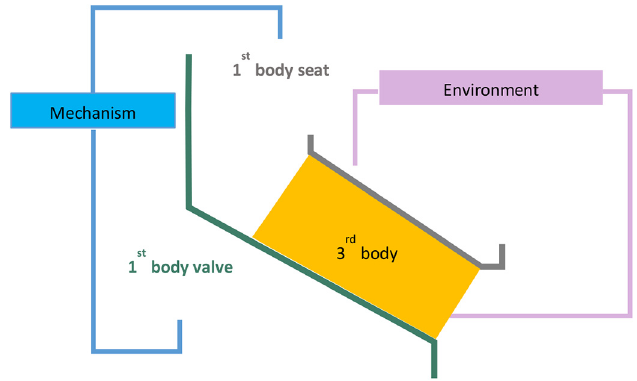
Fig. 4. Tribological de fi nition of the valve-seat